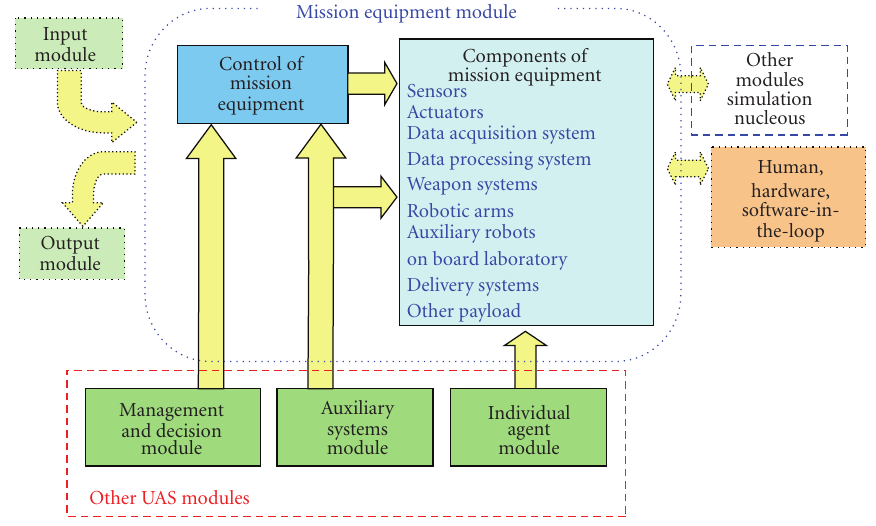
Figure 7: UAS-SE—mission equipment module.